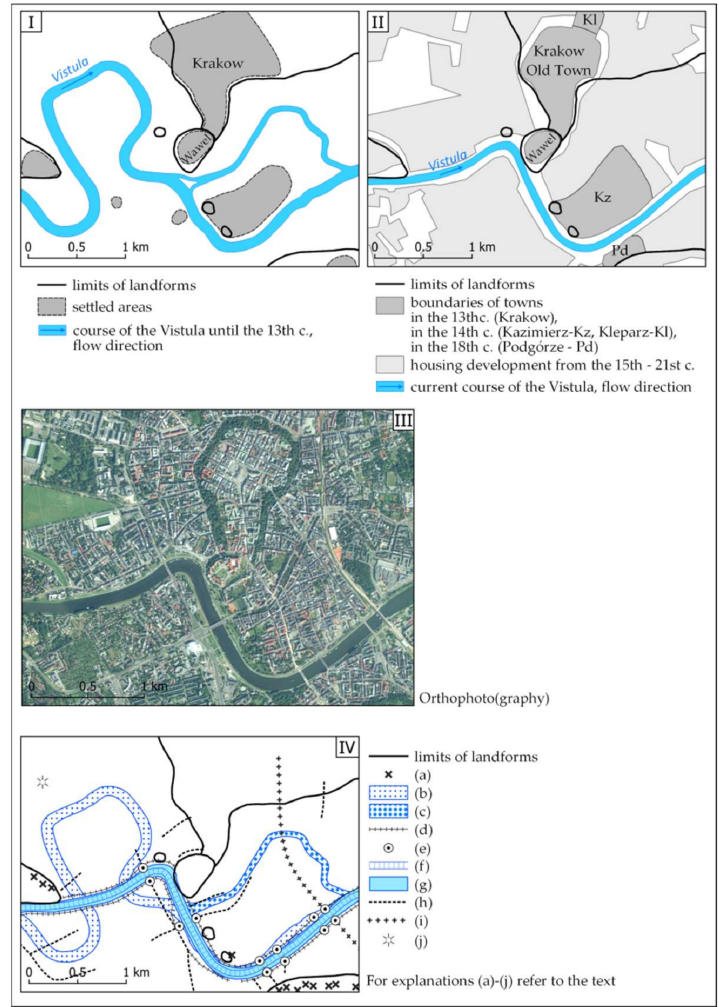
Figure 2. Areas inhabited in contemporary Krakow centre before the 13th century ( I ) and later ( II ). Current built-up areas and areas of recreational use without high housing development ( III ). Areas where spectacular changes in land topography occurred ( IV )